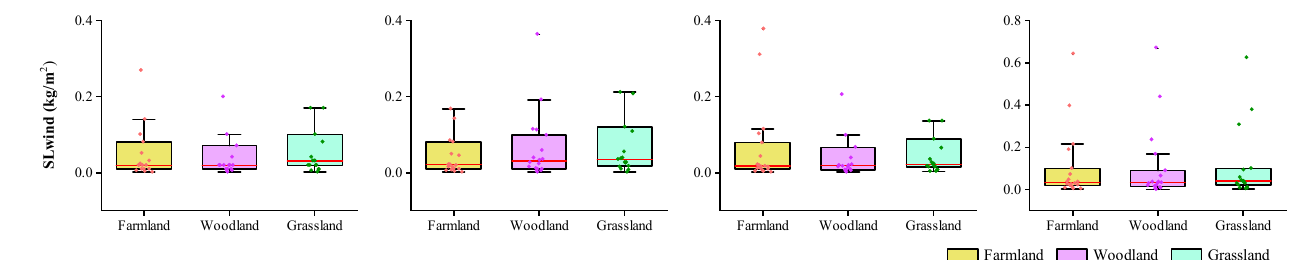
Figure 8. The supply of the six ESs in a different land-use cover (farmland, grassland, and woodland) from 2000 to 2017. The first column ( a ), second column ( b ), third column ( c ) and fourth column ( d ) indicate the distribution of annual mean values of ESs on different land use cover in Duolun County, the agricultural advantage zone (agro-zone), the pastoral advantage zone (pastoral zone) and the semiagricultural and semipastoral zone (agro-pastoral zone), respectively. The first to sixth rows indicate the distribution of annual mean values of food supply (FS), grass production (GP), water yield (WY), carbon sequestration (CS), soil water erosion (SLwater), and soil wind erosion (SLwind) across different land use cover,